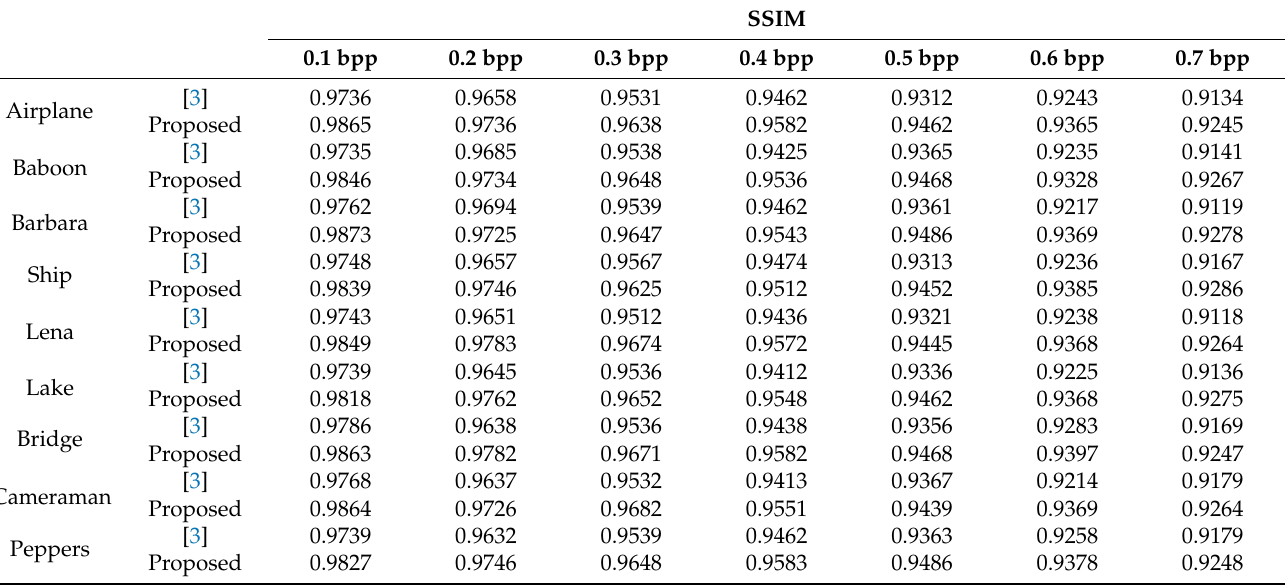
Table 7. A comparison of the SSIM for single-layer